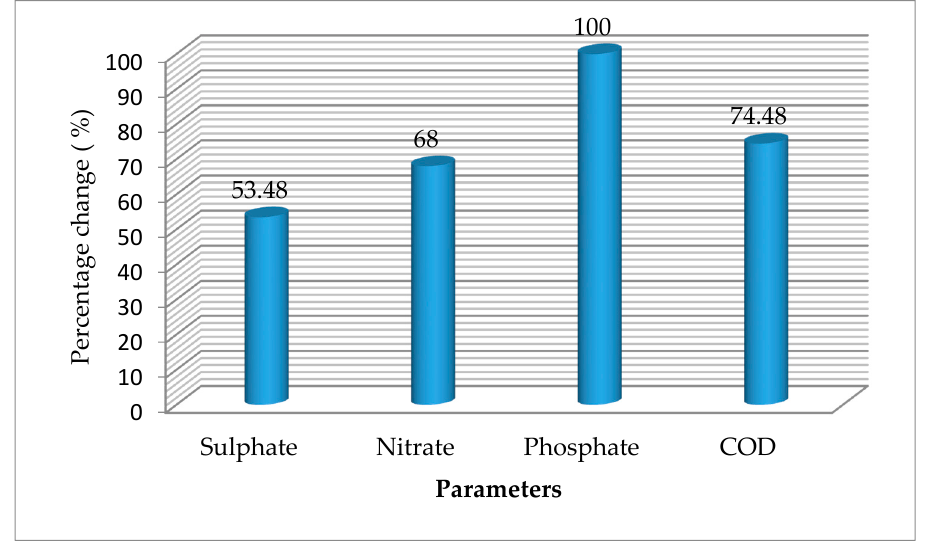
Figure 2. Percentage change in chemical oxygen demand (COD) and anionic parameters of cassava mill effluents after 15 days.